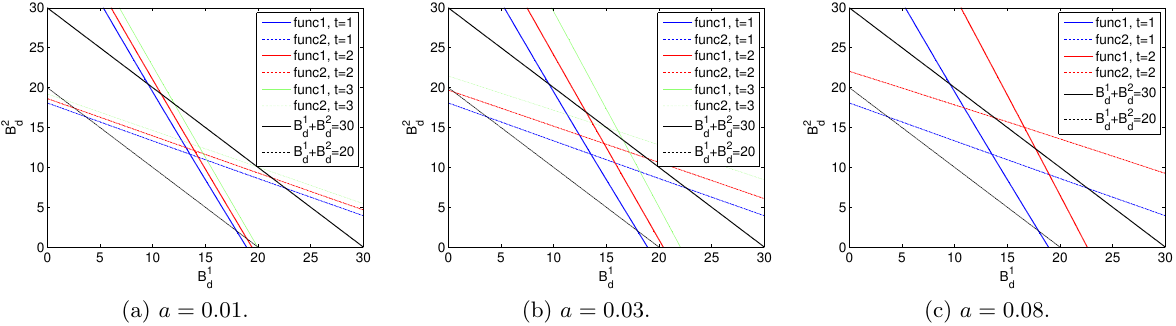
Figure 2: NE evaluations with different a for the first simulation